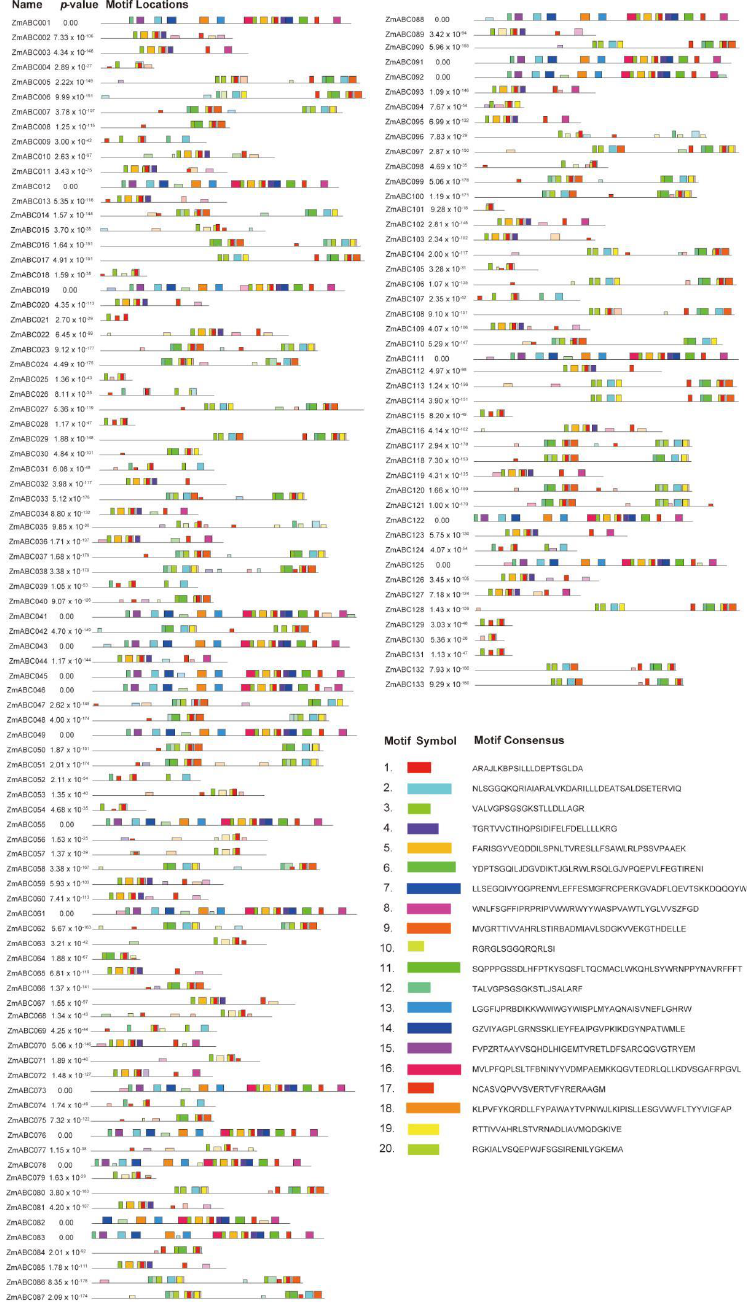
Figure 2. Genomic structure and motif composition of ZmABCs: the conserved motifs in ZmABCs proteins were identified using MEME. Each motif is represented with a specific